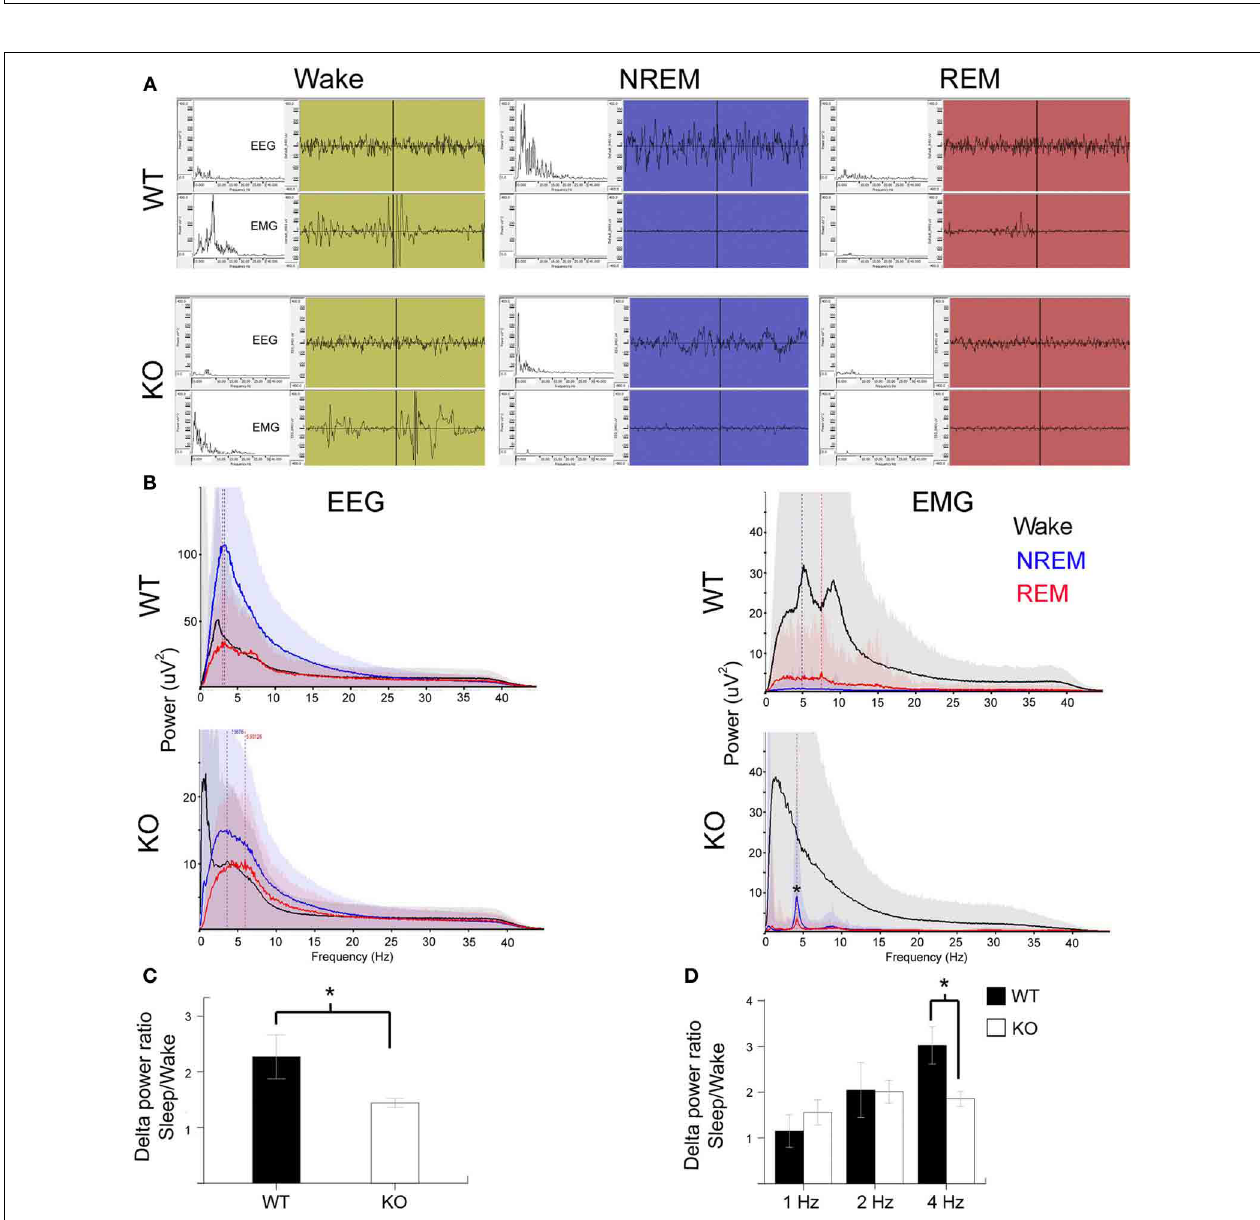
FIGURE 3 | Poor SWA sleep during NREM indicates severe sleep dysfunction in KO mice. (A) Representative 10s EEG traces (top panel) were scored as wake (green), NREM (blue), and REM (red) along with the synchronous EMG (bottom panel) recorded from WT and KO mice. Insets on left are spectrograms for the EEG and EMG for those 10s in the 0.5–40Hz range (left to right). EEG spectrogram showed that KO mice had poor power in the delta range (0.5–4Hz) that is typical of SWA sleep during NREM compared to WT mice. Note WT REM shows a typical muscle twitch artifact on EMG. (B) Power analyses for the same mice represented in EEG traces for the 24h scoring showed a severe